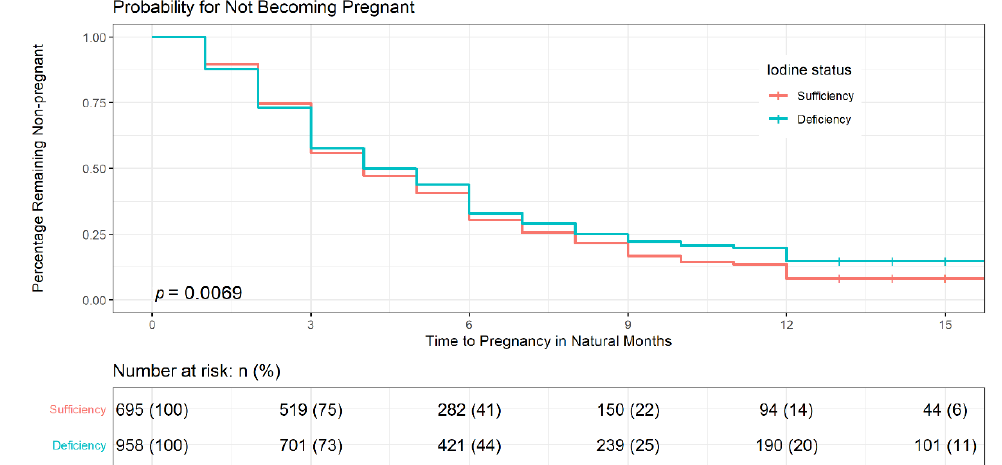
Figure 2. Distribution of time to pregnancy by iodine intake via Kaplan–Meier survival curves. Log- rank test was used to assess the difference in time to conceive between participants with iodine sufficiency and iodine deficiency ( p = 0.007). Kaplan–Meier survival estimates showed that partici- pants with iodine deficiency took a longer time to get pregnant than those with iodine-sufficiency. +: censoring